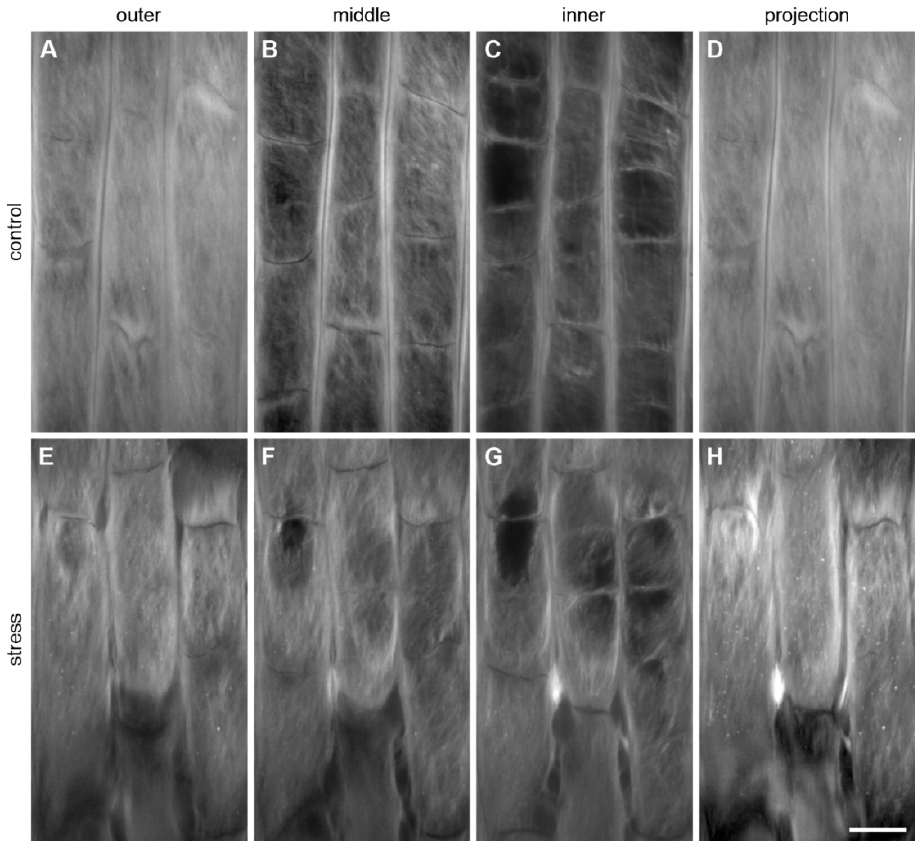
Figure A1. Orientation of cellulose fibrils in successive lamellas of the outer periclinal cell wall of the protoderm (L1) in control ( A – D ) and stressed ( E – H ) roots. The orientation of microfibrils changes from longitudinal or diagonal in the outermost lamella ( A , E ), through more oblique in the middle lamellas ( B , F ) to close to transverse in the innermost lamellas ( C , G ). ( D , H ) ImageJ maximum projection of z-stack through the L1. Scale bar referring to all images: 10 μm.